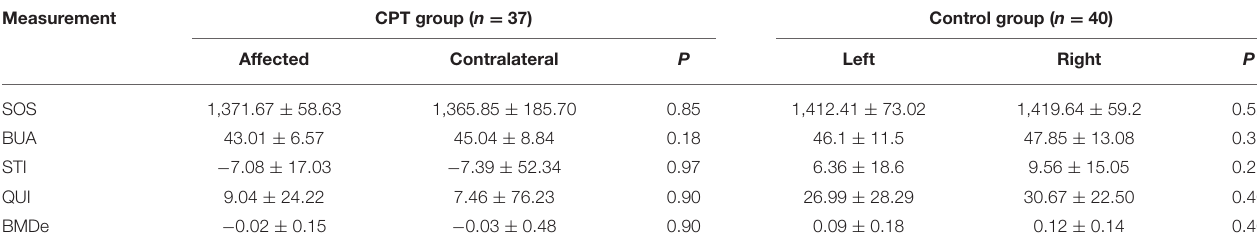
TABLE 3 | Intragroup differences in the measurements of quantitative ultrasound. Measurement CPT group ( n = 37) Affected